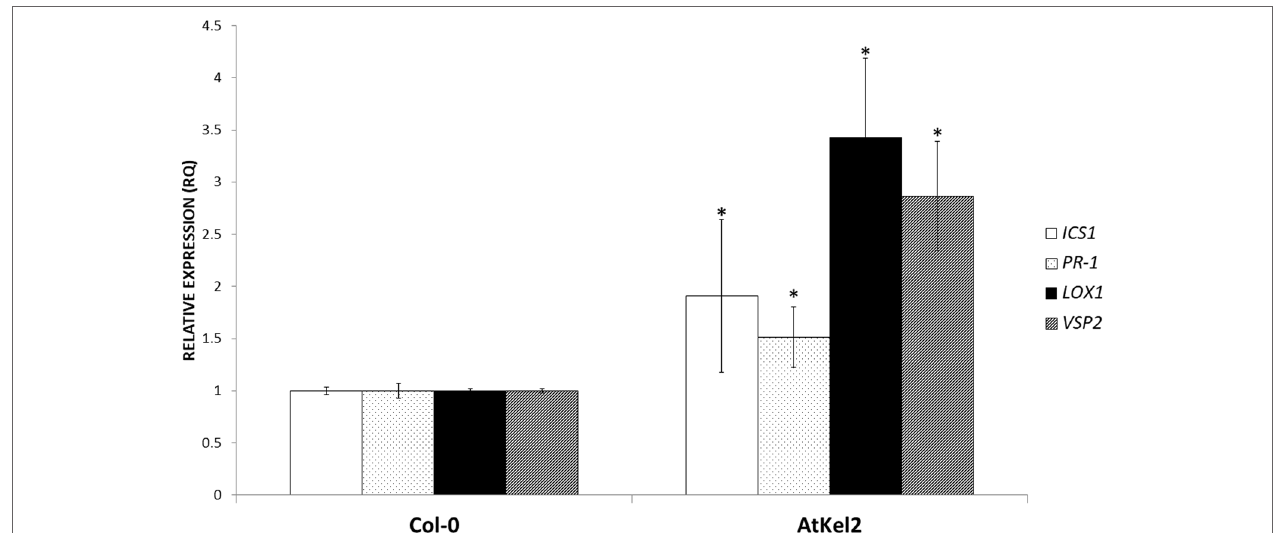
FIgURE 3 | Quantitative reverse transcription polymerase chain reaction (RT-qPCR) analysis of the expression of some defense genes in the leaves of A. thaliana wild-type plants (Col-0) and the transgenic line AtKel2 (5-week-old plants). Genes of the isochorismate synthase 1 ( ICS1 ), pathogenesis-related protein 1 ( PR-1 ), lipoxygenase 1 ( LOX1 ), and vegetative storage protein ( VSP2 ). Values correspond to relative measurements against Col-0 (2 –ΔΔCt = 1). The Arabidopsis actin gene was used as an internal reference gene. Data are the mean of three biological replicates for each condition with the corresponding standard deviation, and for each biological replicate and condition, two leaves per plant from five plants were used. Student’s t-test was performed. Asterisks denote significant differences at P ≤ 0.05.